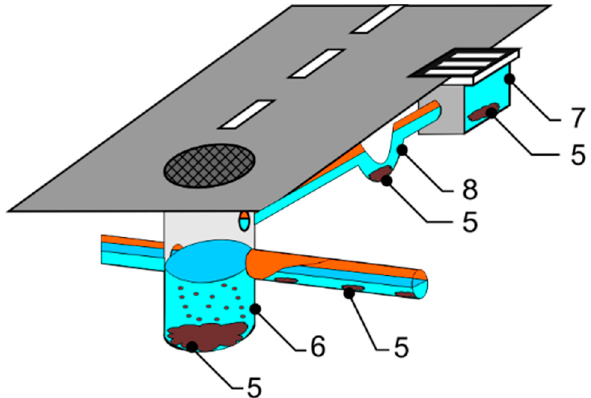
Figure 2. Accumulation of sewage in combined sewerage/stormwater drainage systems: 5—sewage accumulation, 6—sediment wells, 7—roadside inlets, 8—siphons.